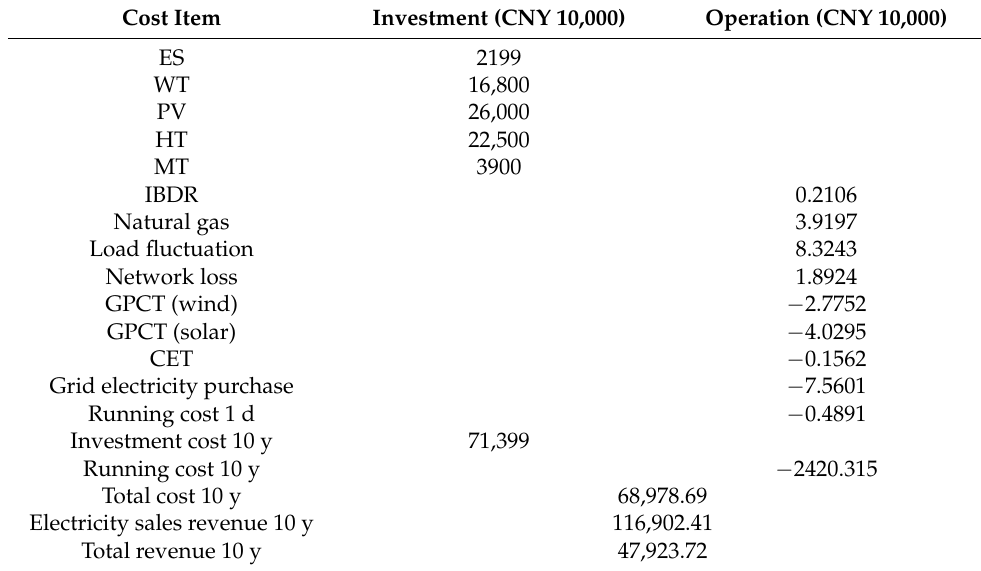
Table 6. PG&E69 NDN planning and simulation operation cost considering GPCT and